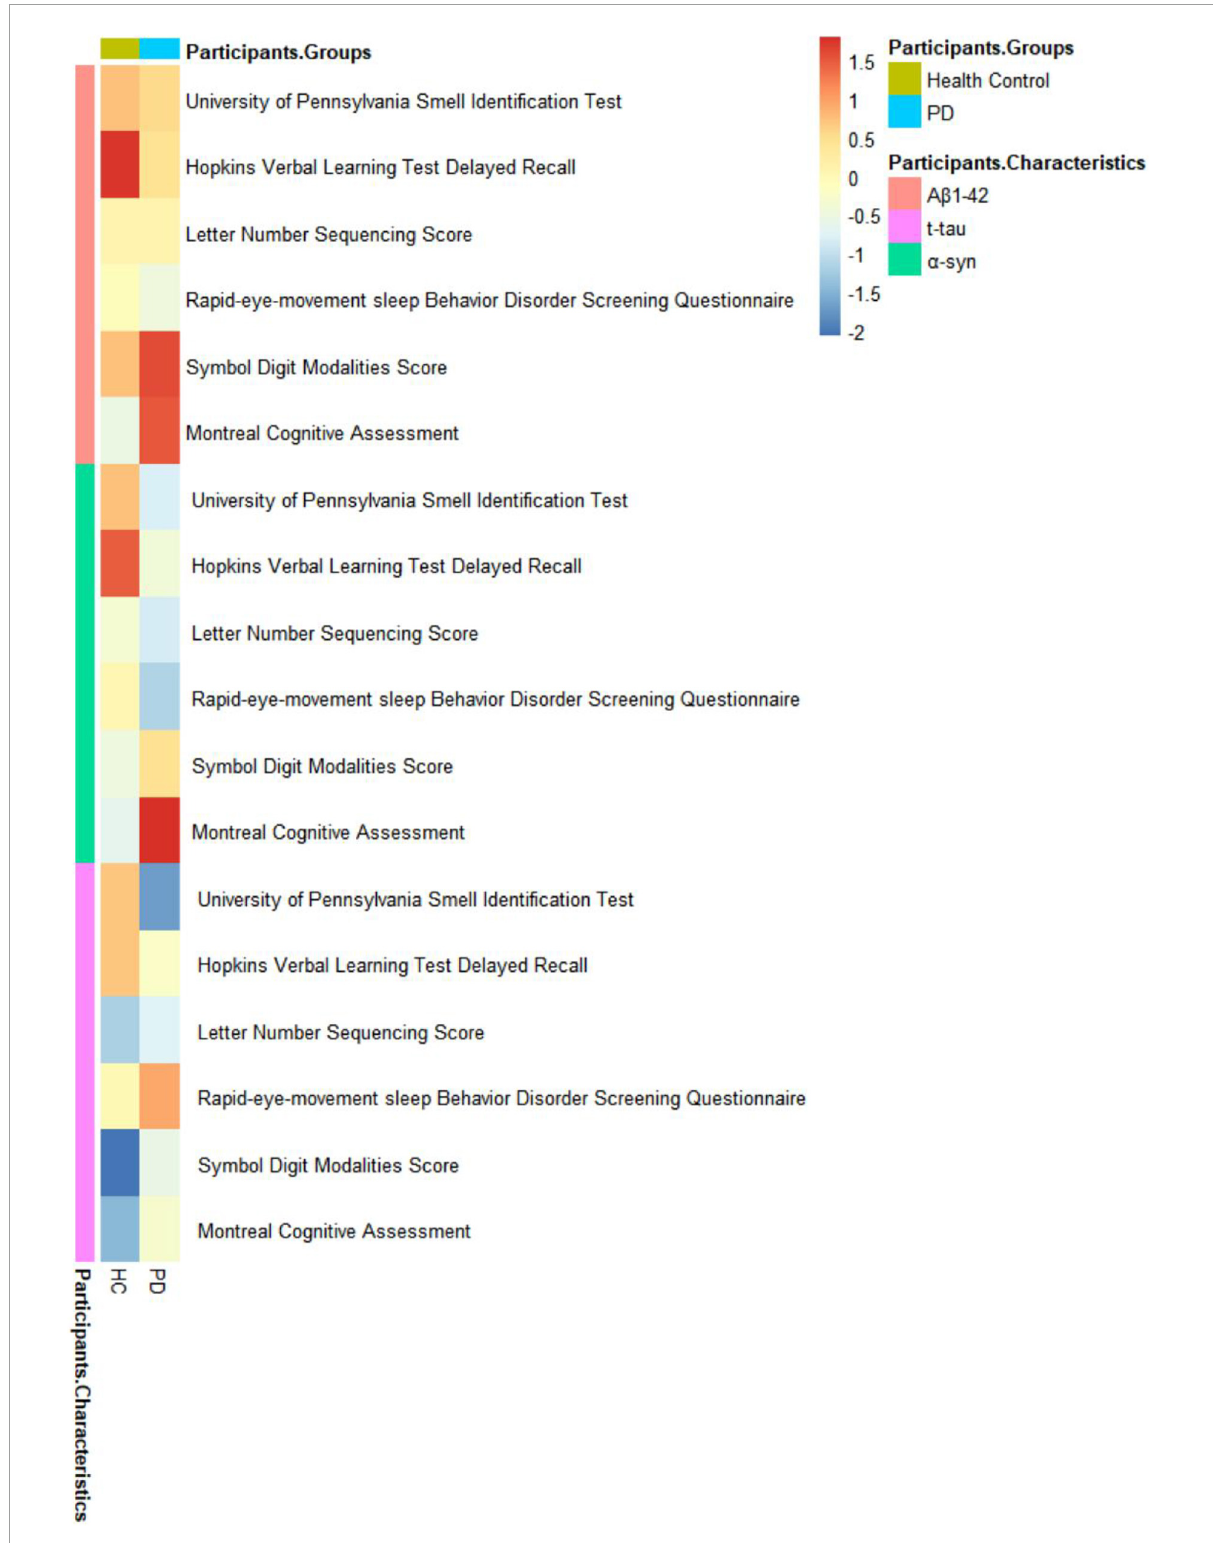
FIGURE1 Associations of non-motor symptoms with cerebrospinal fluid (CSF) biomarker levels in cross-sectional analyses.